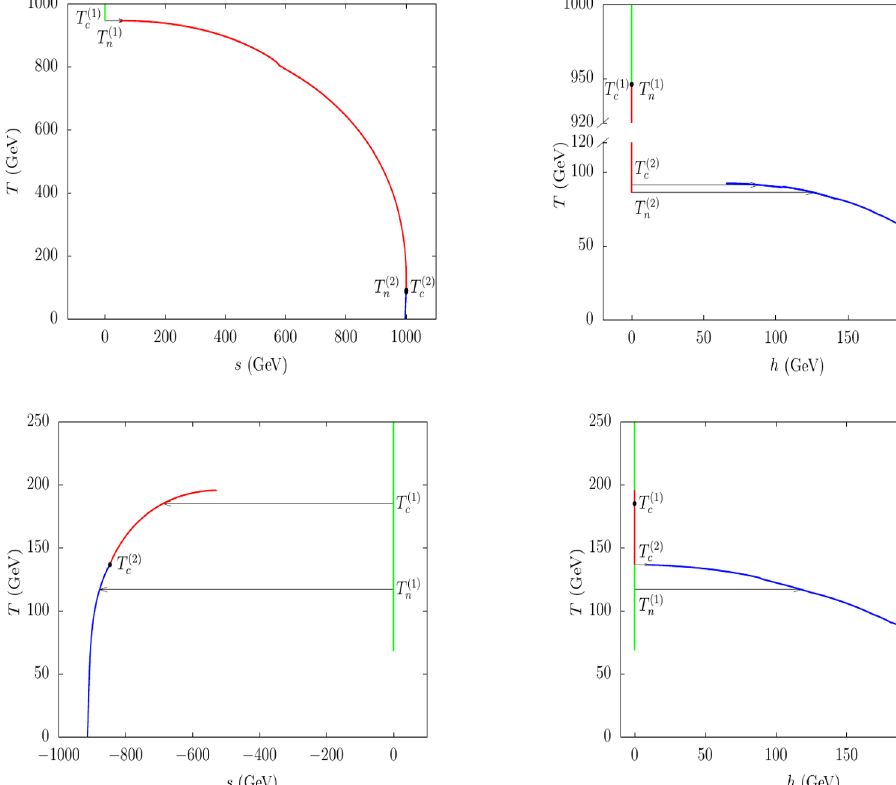
Figure 2. Phase flows in benchmark scenarios BP-A2 and BP-A4. Each color stands for a particular minimum of the potential (phase) while the individual lines represent the evolution of the phase in different field directions (along the singlet direction s (left) and along the SU(2) -direction p + h 2 (right) as a function of temperature. For each phase transition denoted are the h = h 2 u d T c and T n . The arrows represent the directions of transition from the false to the true vacuum as obtained from the calculations at T and T in the corresponding field space whereas a bullet c n in black denotes that along this transition the corresponding field value does not alter too